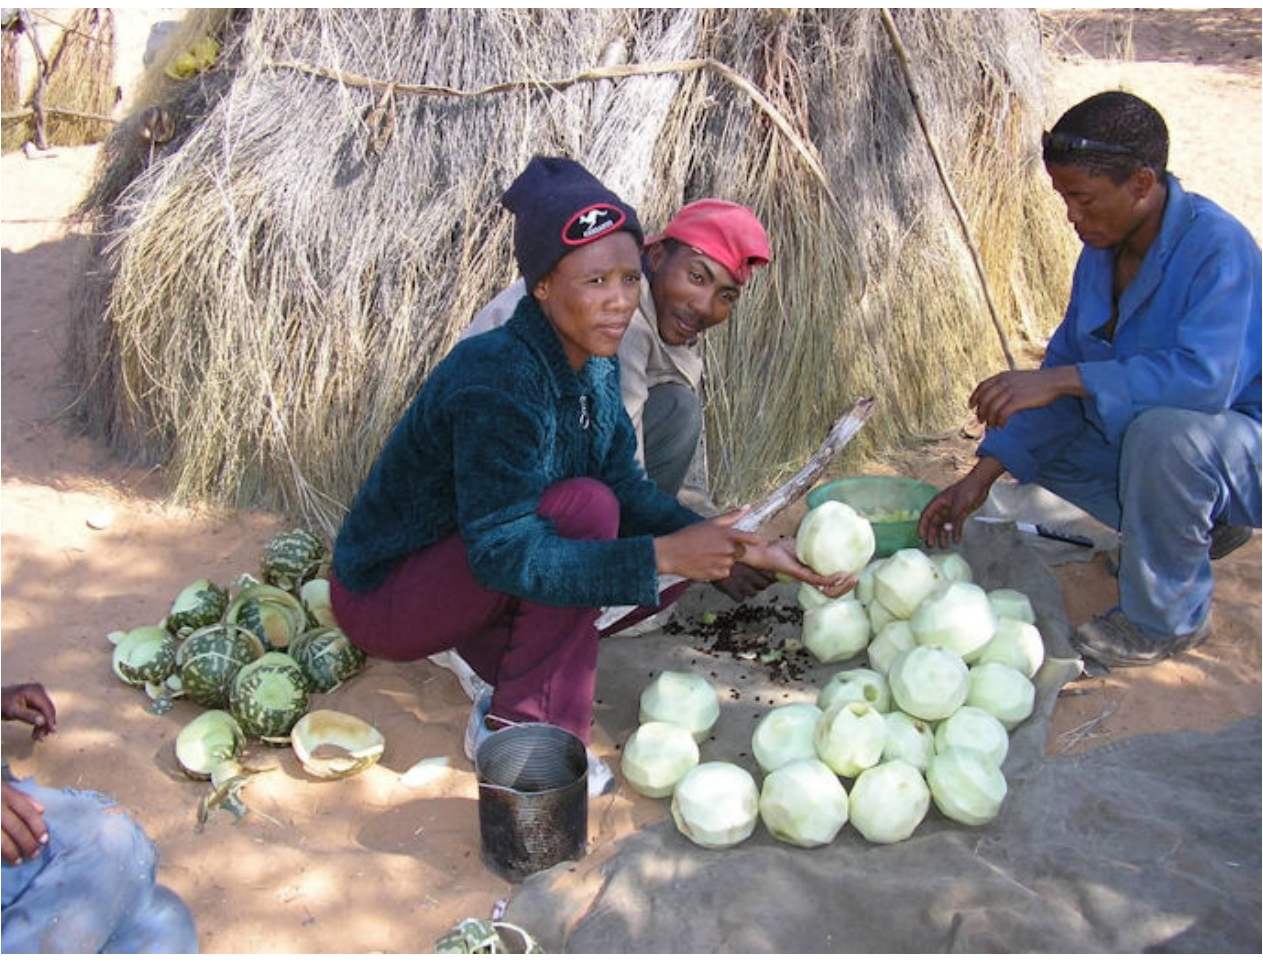
Fig. 6 . Villagers separating Citrullus lanatus flesh and seeds at a temporary camp, 40 km from Khawa settlement, August 2004. Flesh is heated to form water, and the seeds are pounded into flour for